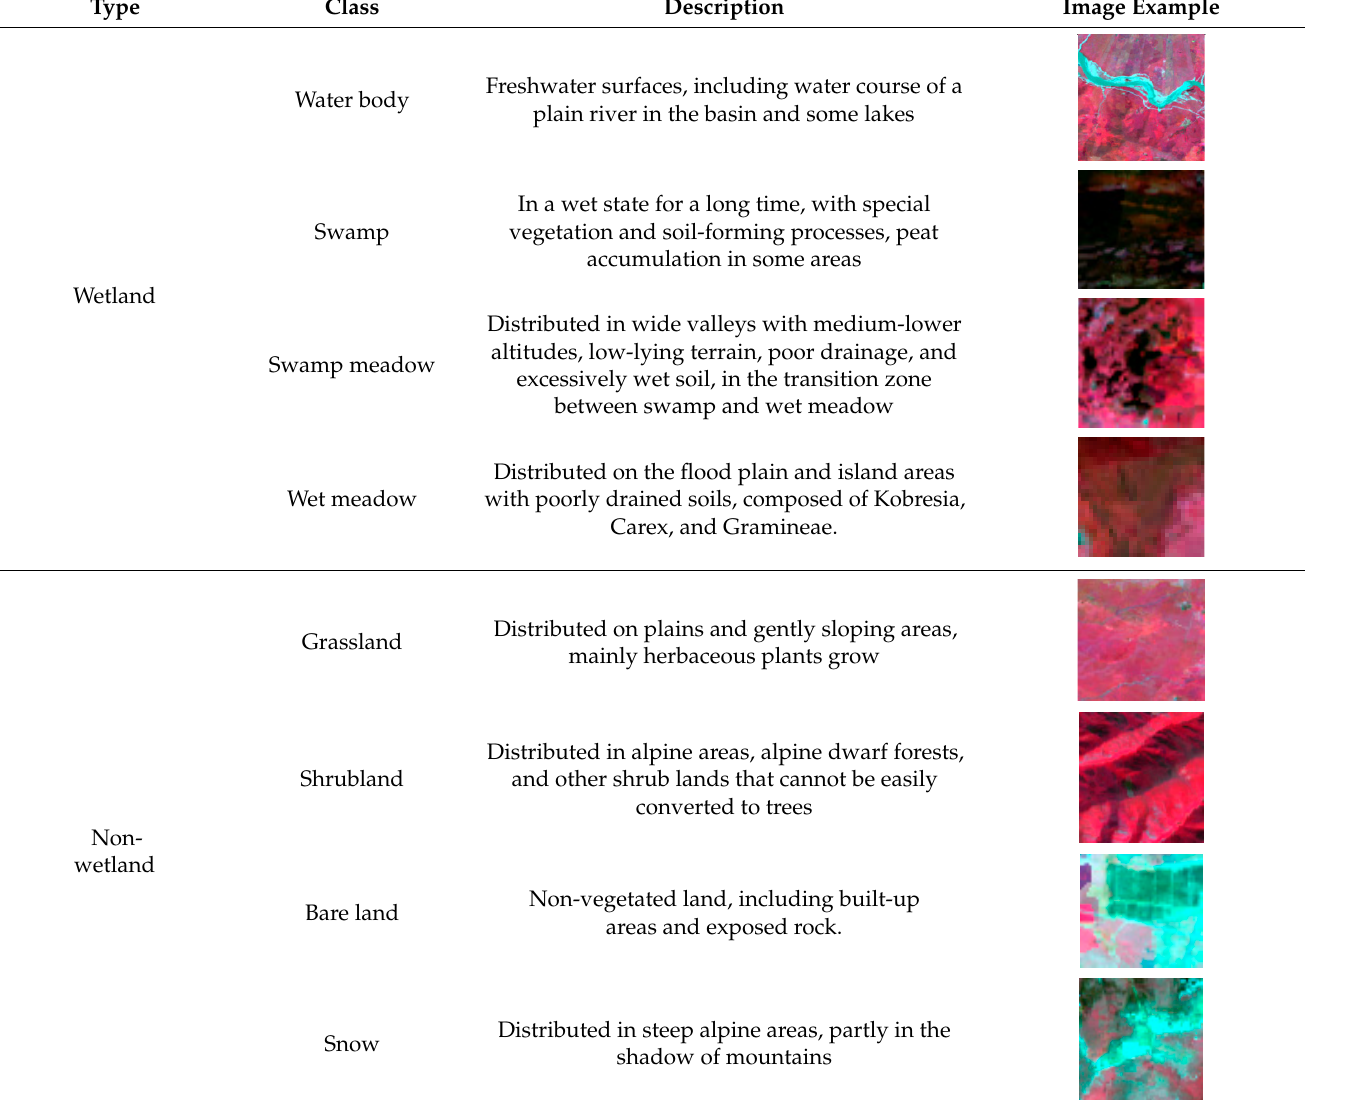
Figure 2. Flowchart of the long-term time series wetland change detection and analysis of the driving climate forces. Table 2. Landsat image data for the study area used in this study.